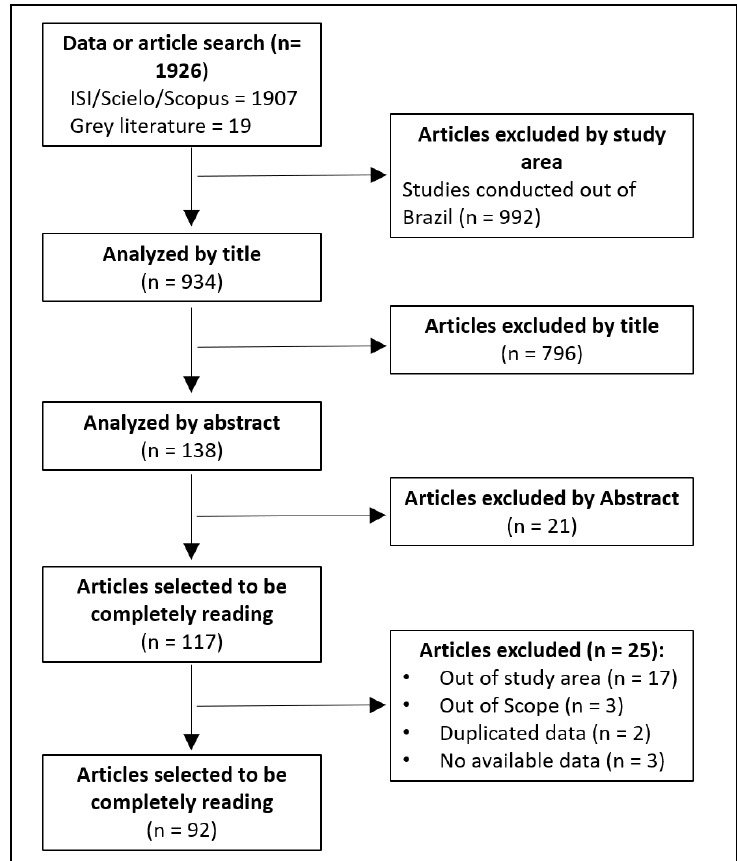
Figure 2. Flowchart based on the Preferred Reporting Items for Systematic Reviews and Meta-Analyses (PRISMA) model for selection of papers to be